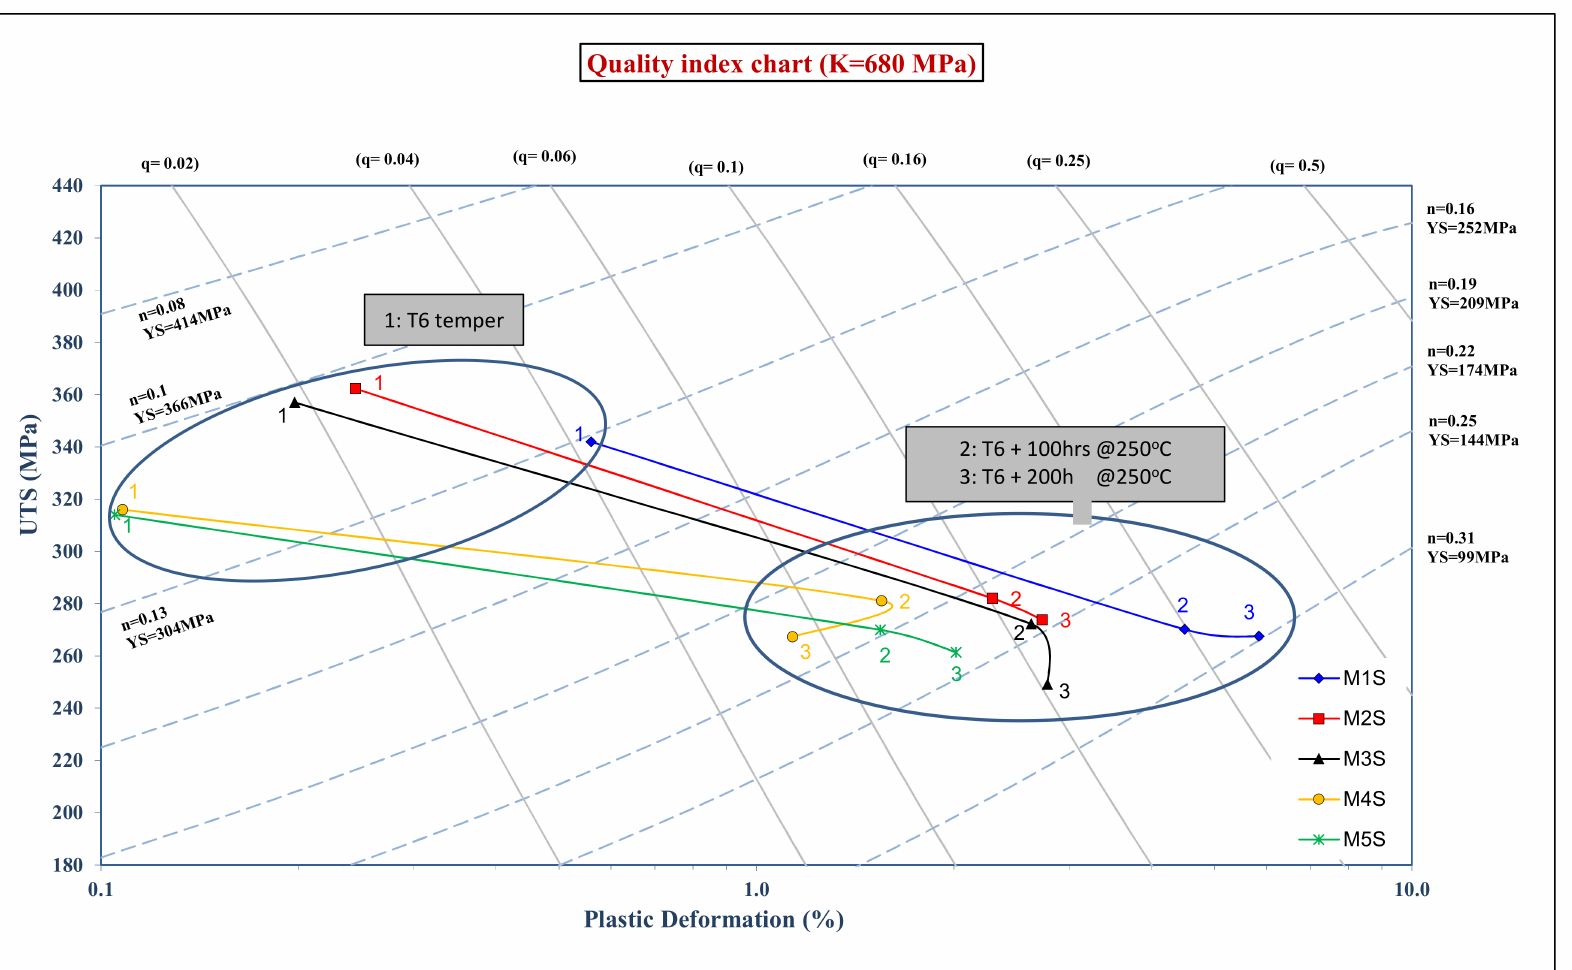
Figure A2. C á ceres quality chart representing the relation between UTS and percent plastic deformation of alloys M1S through M5S in the T6 condition before and after stabilization at 250 ◦ C for 100 and 200 h (testing at ambient